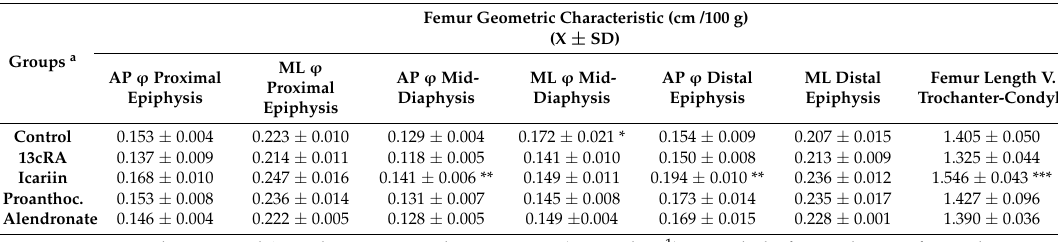
Table 4. Effect of icariin, proanthocyanidins and alendronate on femur geometric characteristics in rats with retinoic acid-induced bone